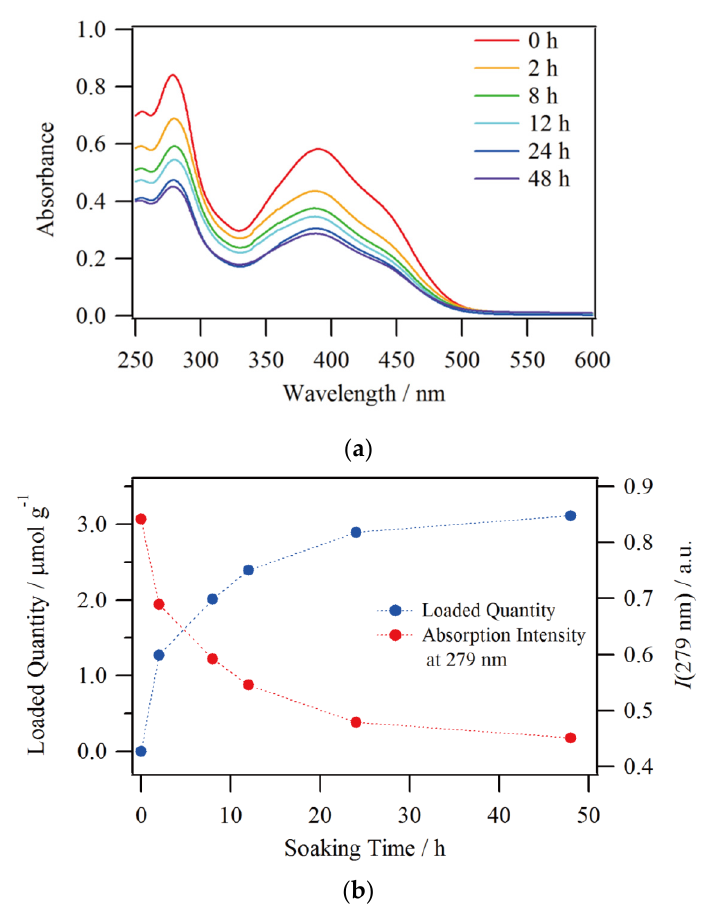
Figure 5. Soaking time dependence of ( a ) UV-Vis absorption spectra and ( b ) loaded quantity of 1 @Nafion.